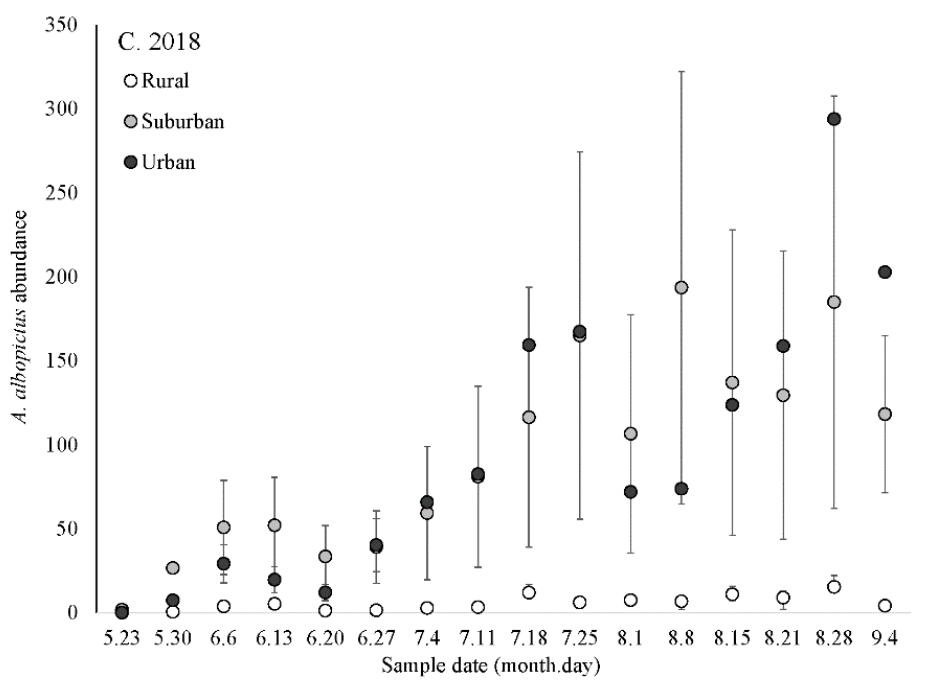
Figure 2. Abundance of A. albopictus larvae collected from oviposition cups. ( A ) The interaction between land use type and sample year. ( B ) The interaction between sample week and land use type in 2017 and ( C ) 2018.